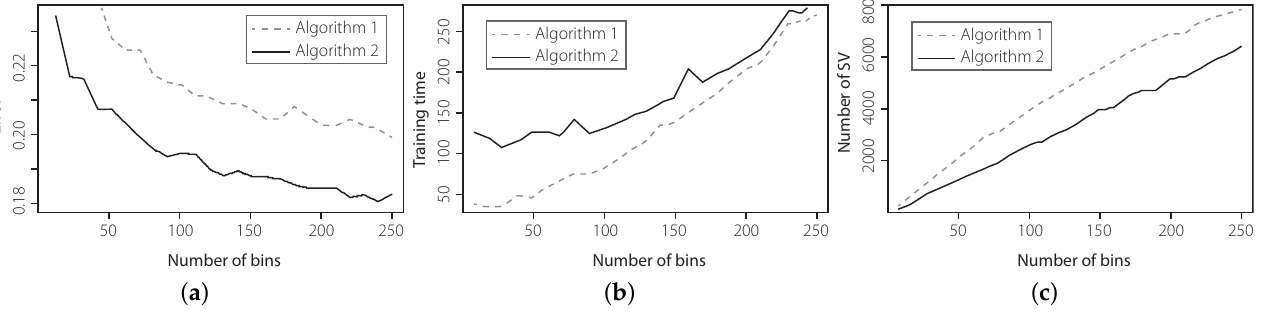
Figure 2. Plots of the effect of changing the number of bins over error ( a ), time ( b ) and number of SV ( c ) for data set covtype.binary.